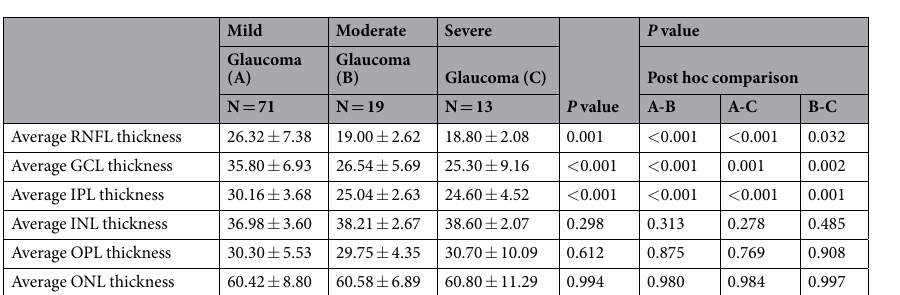
Table 2. Average RNFL, GCL, IPL, INL, OPL, and ONL thicknesses in the macular area of glaucoma patients using Spectral-domain optical coherence tomography. RNFL = retinal nerve fiber layer; GCL = ganglion cell layer; IPL = inner plexiform layer; INL = inner nuclear layer; OPL = outer plexiform layer; ONL = outer nuclear layer. * Comparison among the three groups by Kruskal-Wallis One-way analysis of variance.